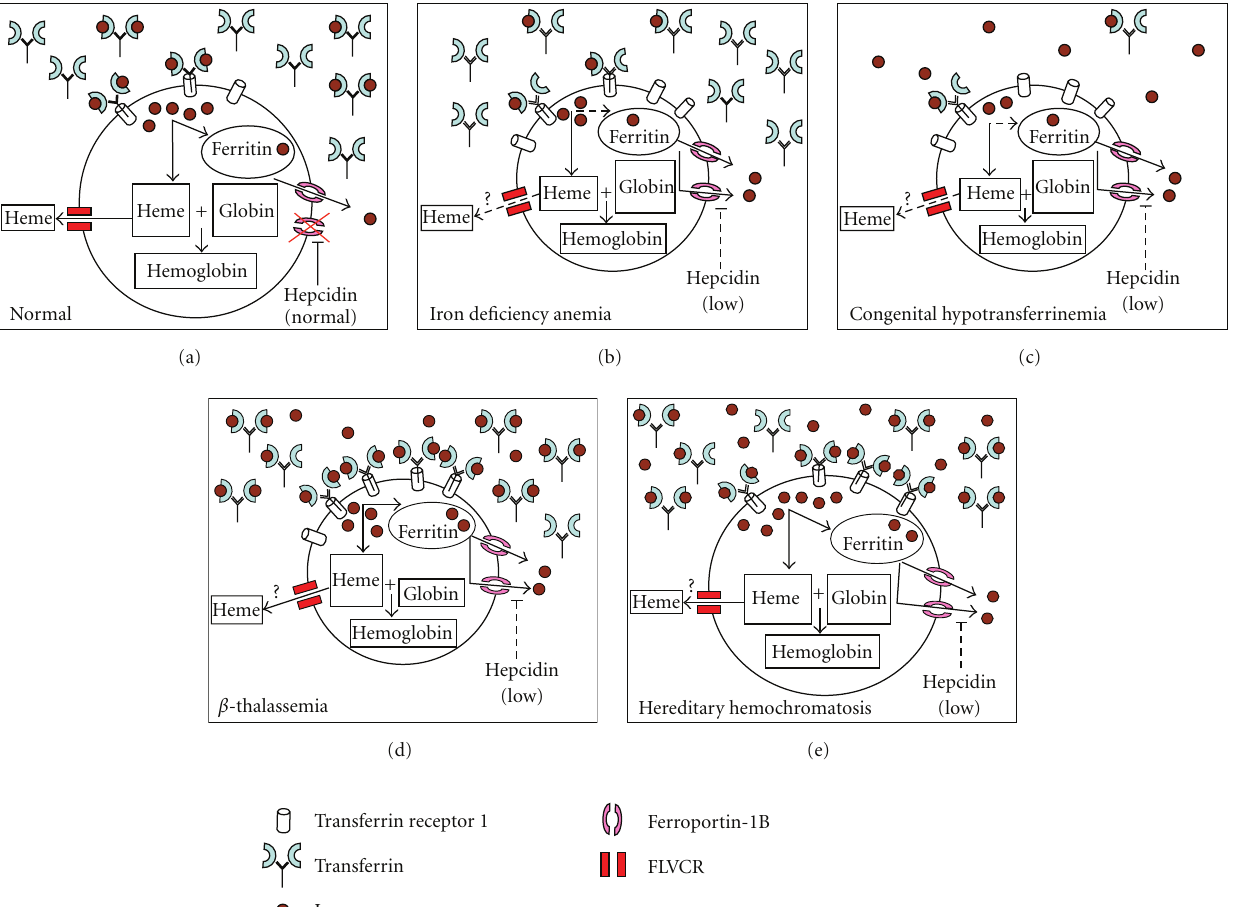
Figure 1: Model relationship between iron delivery, relative abilities to synthesize heme and globin, and heme and iron export in various diseases associated with concurrent iron and erythroid